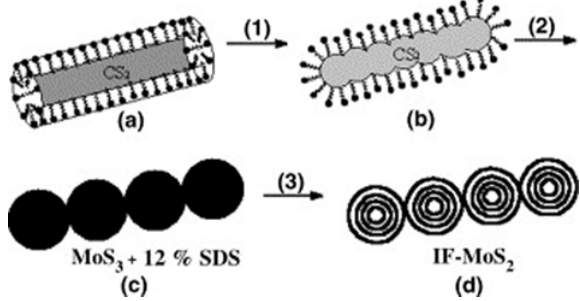
Figure 4. Schematic illustration for the formation of fullerene-like MoS nano-necklace: (1) 2 SDS aggregations transform from rod-like to spherical micelles with the increase of temperature. (2) The necklace-shaped assembly of amorphous MoS nanospheres with 12 wt 3 % SDS forms is realized by the aggregation transformation of surfactants. (3) The fullerene-like structures produces from the amorphous necklace-shaped assembly of MoS 2 MoS nano-necklace, after removing the residual SDS by annealing treatment. Reproduced 3 from reference [75] with permission from